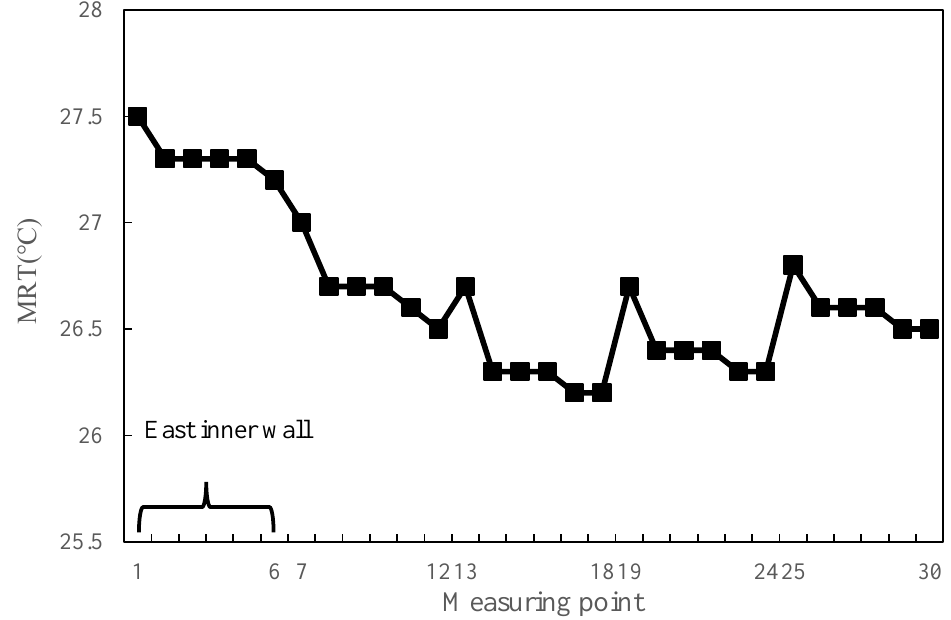
Figure 16. Horizontal distribution of MRT under constant flow control.